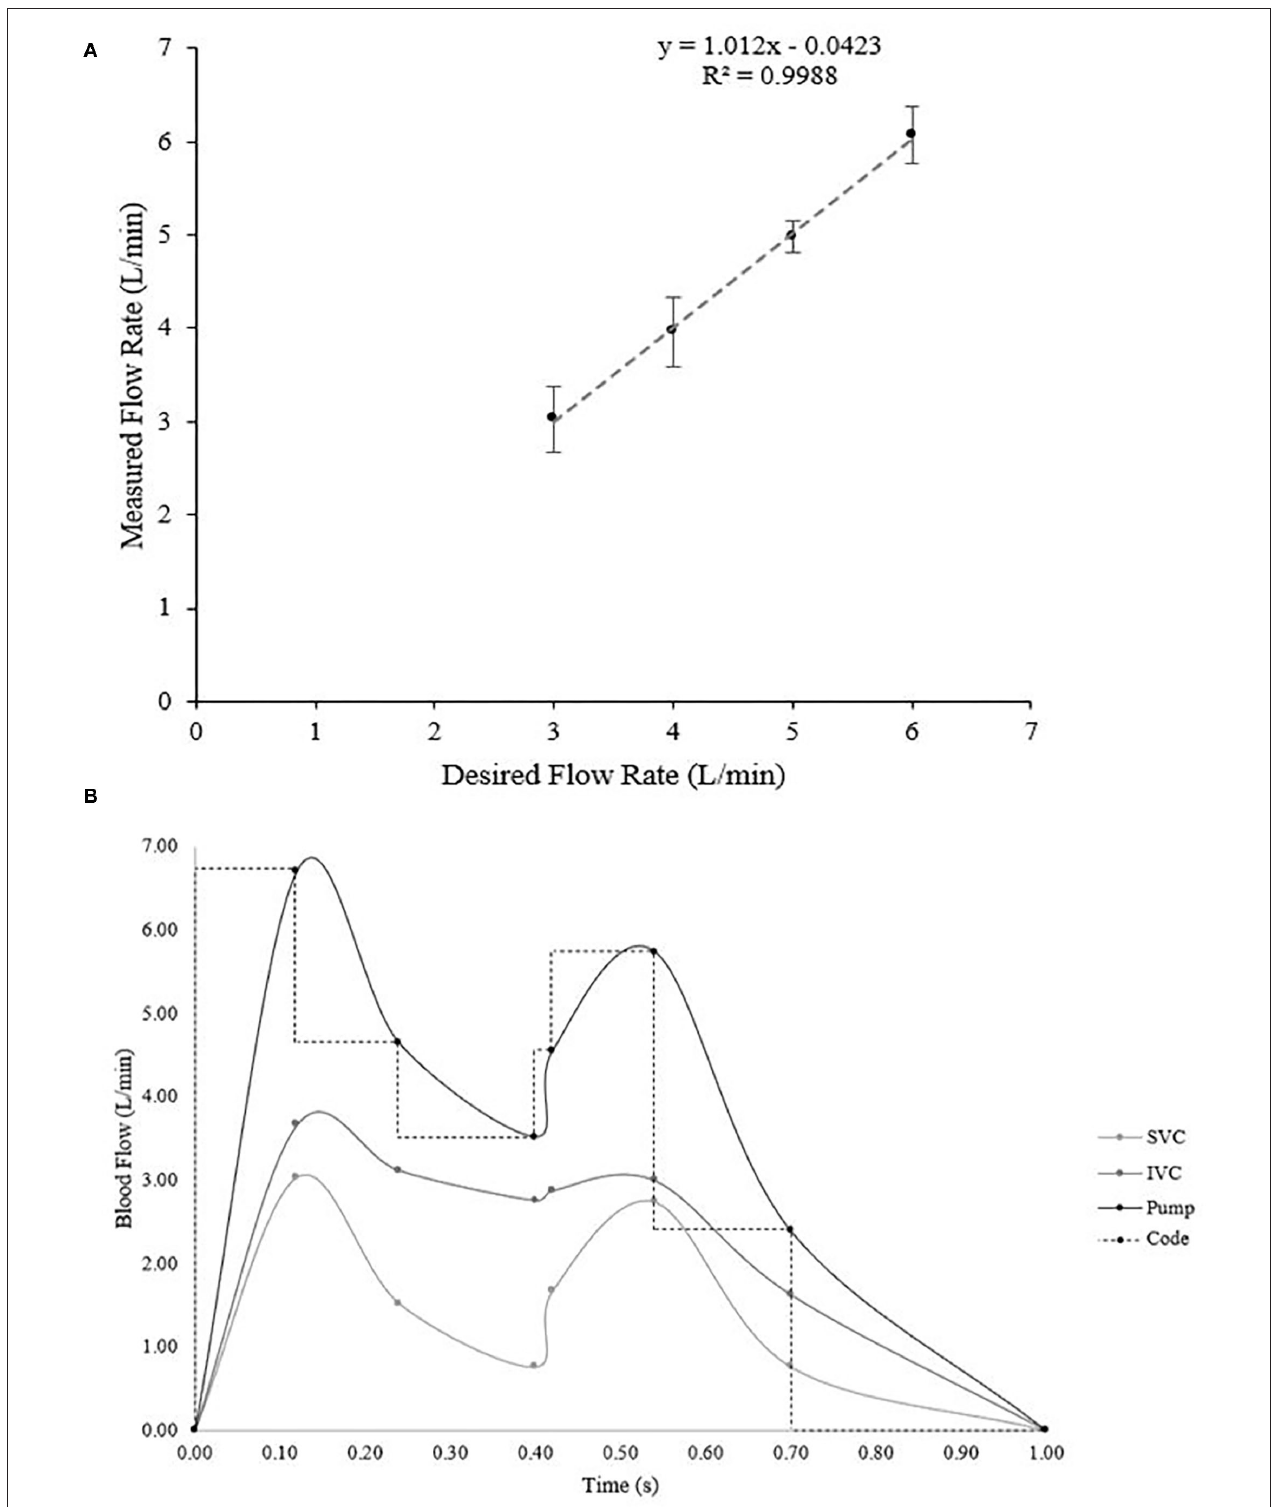
FIGURE 5 | (A) Verification of the flow rate during various constant flow rate trials ranging from 3–6 L/min. Ideally, the linear relationship would be y = x, which our calculated equation of y = 1.012 × − 0.0423 is very close to (R-squared value in linear regression is 0.9988). (B) Calculated flow profiles during pulsatile flow. The inferior and superior vena cava profiles were obtained based on data from literature (39, 40) and then the pump output necessary to create those two profiles was calculated via fluid dynamics principles. Then the Arduino code was set to mimic the function in steps.